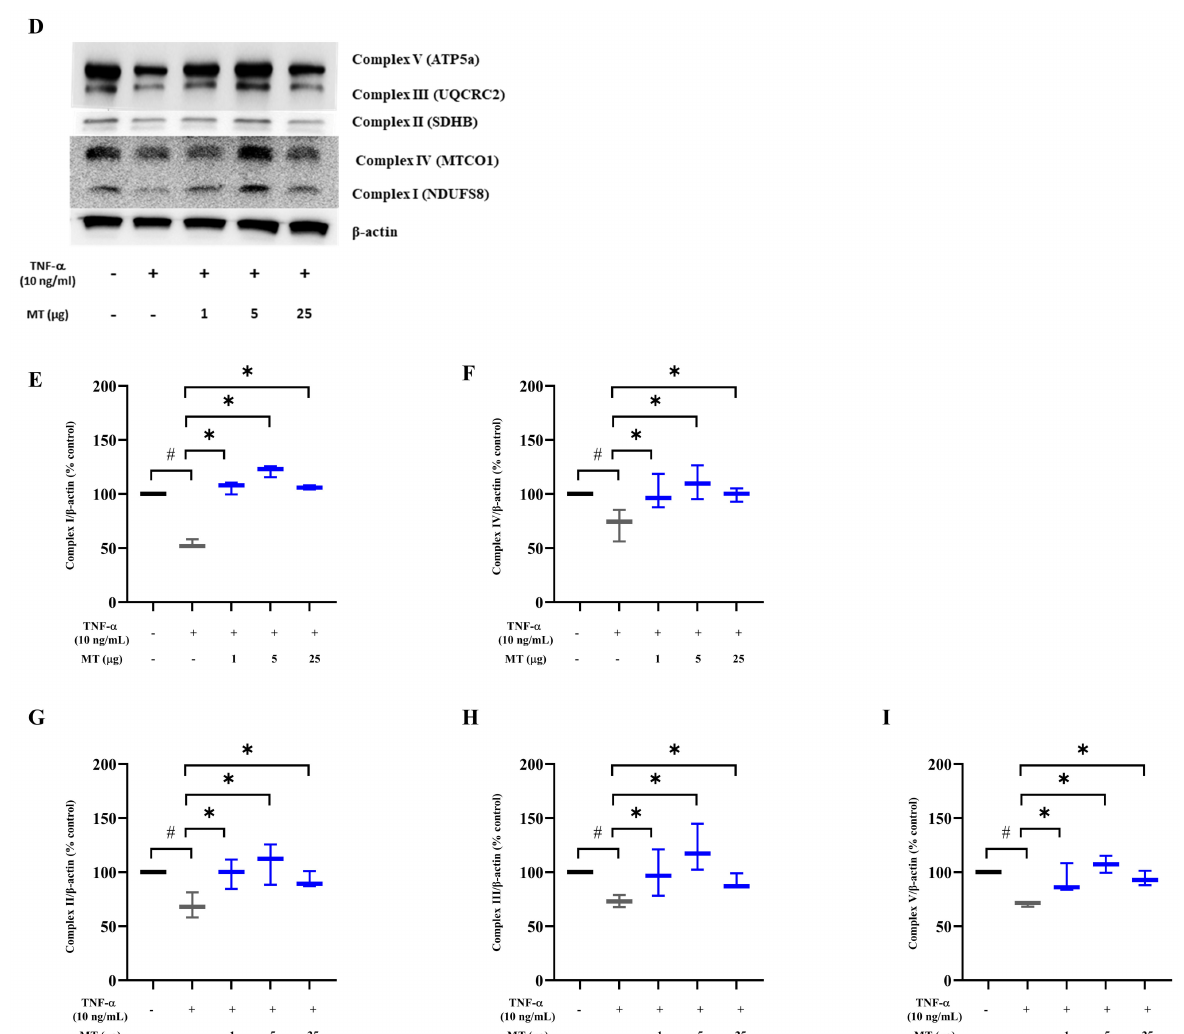
Figure 2. Mitochondrial transplantation reduces elevated oxidative stress, restoring electron transport chain complexes. ( A – C ) Effect on oxidative stress and ATP production: changes in ( A ) intracellular ROS (H 2 O 2 : positive control group inducing intracellular oxidative stress); ( B ) MMP (CCCP: positive control group as mitochondrial oxidative phosphorylation uncoupler), and ( C ) ATP production. ( D – I ) Effect on mitochondrial OXPHOS complex proteins: ( D ) representative western blots of mitochondrial OXPHOS complex proteins and ( E – I ) densitometric quantification of each complex: ( E ) complex I (NDUFS8), ( F ) complex IV (MTCO1), ( G ) complex II (SDHB), ( H ) complex III (UQCRC2), and ( I ) Complex V (ATP5a) ( β -actin as loading control). Data represent mean ± standard deviation (SD) ( n = 3). # p < 0.05 between TNF- α (+) group (black) and TNF- α ( − ) group as control (white), * p < 0.05 between MT (+) group damaged by TNF- α (gray) and MT ( − ) group damaged by TNF- α (black) TNF- α , tumor necrosis factor- α ; MT, mitochondria; DCF-DA, dichlorodihydrofluorescein diacetate; H 2 O 2 , hydrogen peroxide; ROS, reactive oxygen species; MMP, mitochondrial membrane potential; CCCP, carbonyl cyanide m-chlorophenyl hydrazone; ATP, adenosine triphosphate; OXPHOS, oxidative phosphorylation; NDUFS8, NADH ubiquinone oxidoreductase core subunit S8; MTCO1, mitochondrially encoded cytochrome C oxidase 1; SDHB, succinate dehydrogenase complex iron-sulfur subunit B; UQCRC2, ubiquinol-cytochrome c reductase core protein 2; ATP5a, ATP synthase F1 subunit